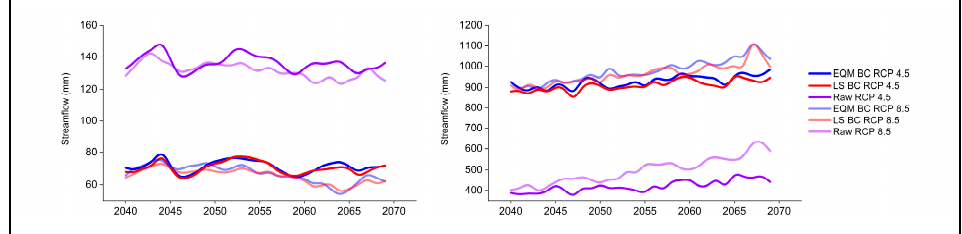
Figure 8. Left panel: inter-annual time-series of 7-day minimum streamflow, as provided by the ensemble mean of the 21 NEXGDDP models when they are LS-corrected (LS BC), EQM-corrected (EQM BC), and when their raw outputs (Raw) are considered for the period (2040–2069). Right panel: as left panel, but for 7-day maximum streamflow.